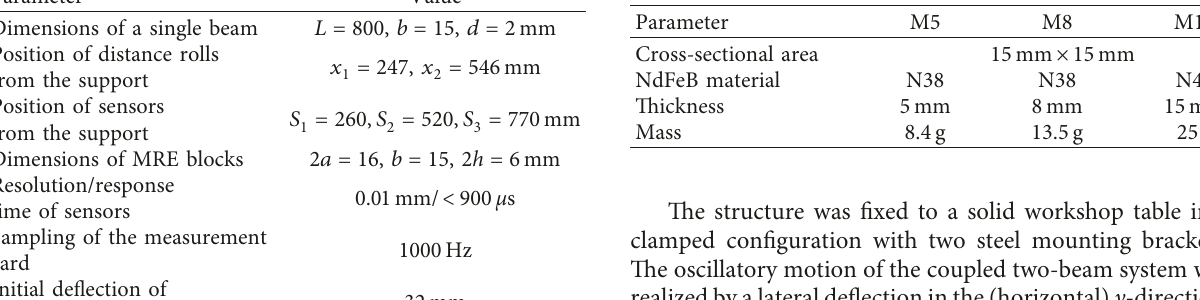
Figure 6: Laboratory two-beam construction system with MR elastomer damper. Table 2: Fundamental parameters of the test rig. Table 3: Neodymium Iron Boron magnets used in the